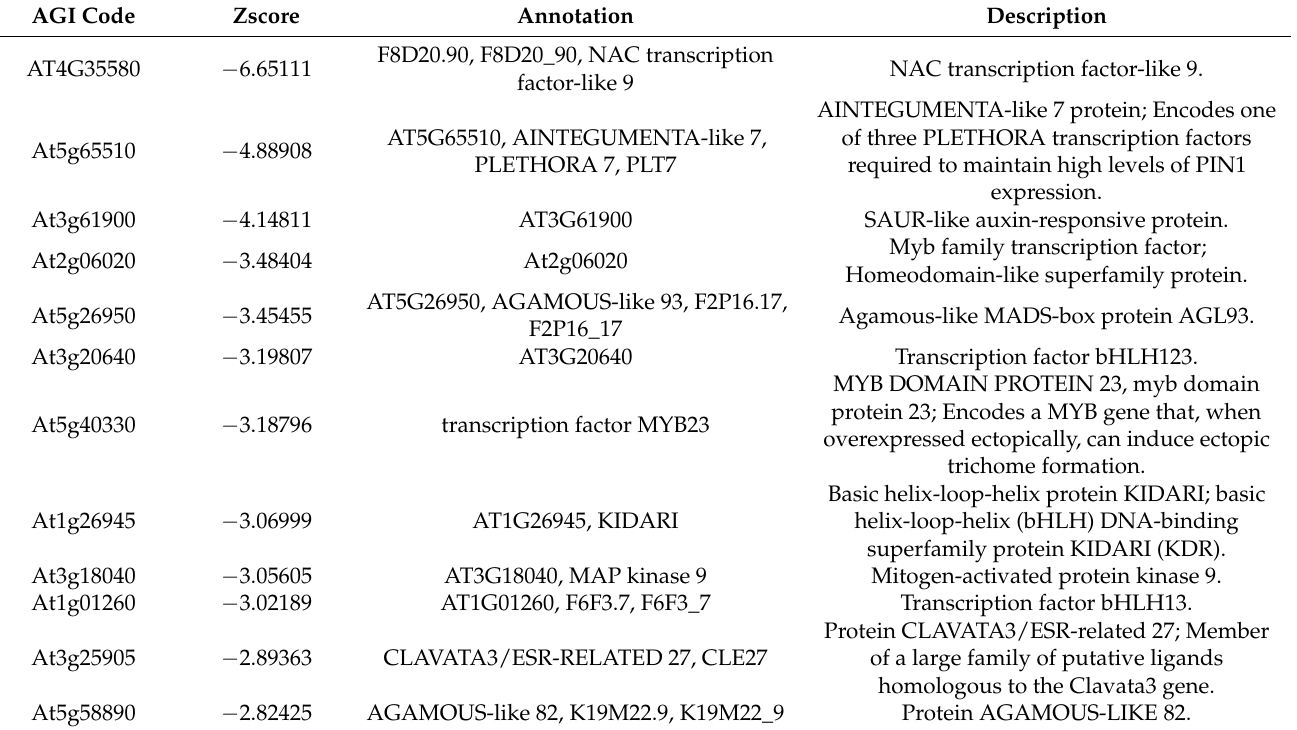
Table 2. Down-regulated genes involved in hormones, stomatal development abiotic stress responses. AGI Code